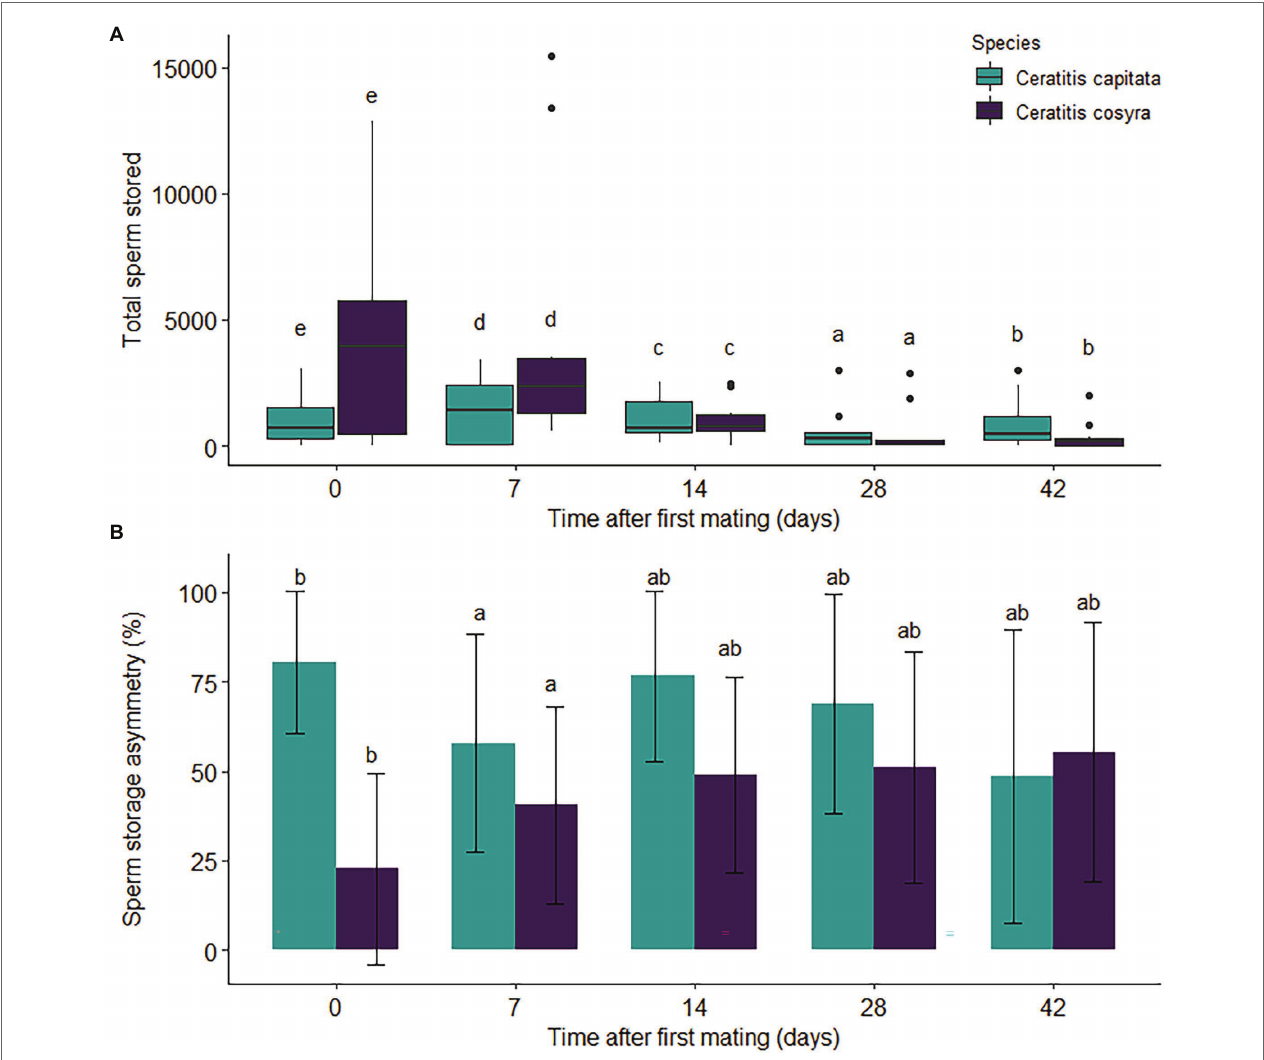
FIGURE 4 | Sperm storage by mated female C. capitata and C. cosyra mated once and kept individually in containers. The values displayed are the (A) total sperm stored and (B) mean (±1 s.e.) percentage sperm storage asymmetry of females over a 42-day period after mating. For both species, each time interval represents 10 dissected females. Time intervals within species with the same lowercase letter are not significantly different (Tukey’s HSD post-hoc tests, α =